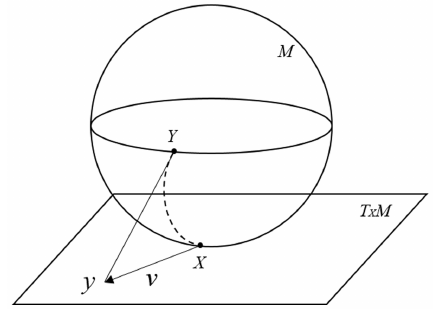
Figure 5. Illustration of the tangent space T X M at point X on a Riemannian manifold. A SPD matrix can be interpreted as point X in the space of SPD matrices. The tangent vector v can be obtained through the logarithm map, i.e. v = log X (Y) . Every tangent vector in T X M can be mapped to the manifold through the exponential map, i.e. exp X ( v ) = Y . The dotted line shows the geodesic starting at X and ending at Y